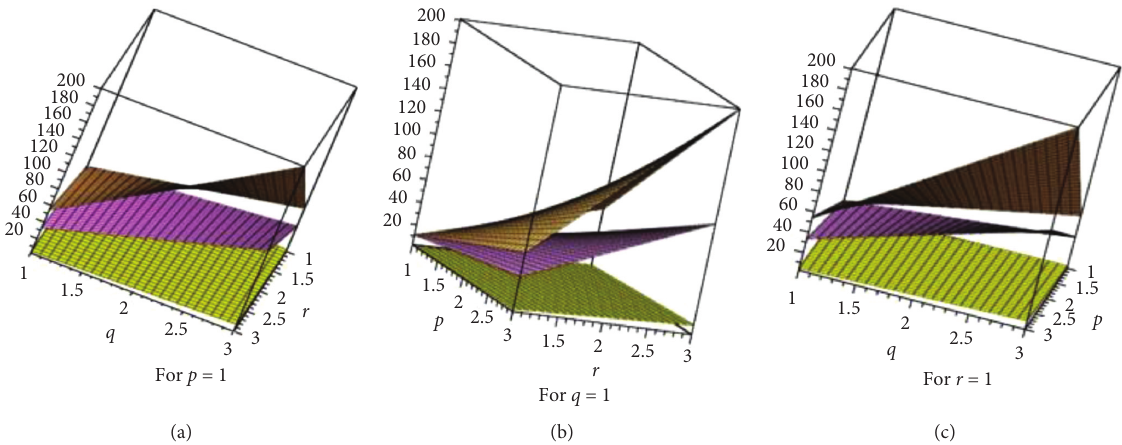
Figure 11: Comparison of IRL , IRD